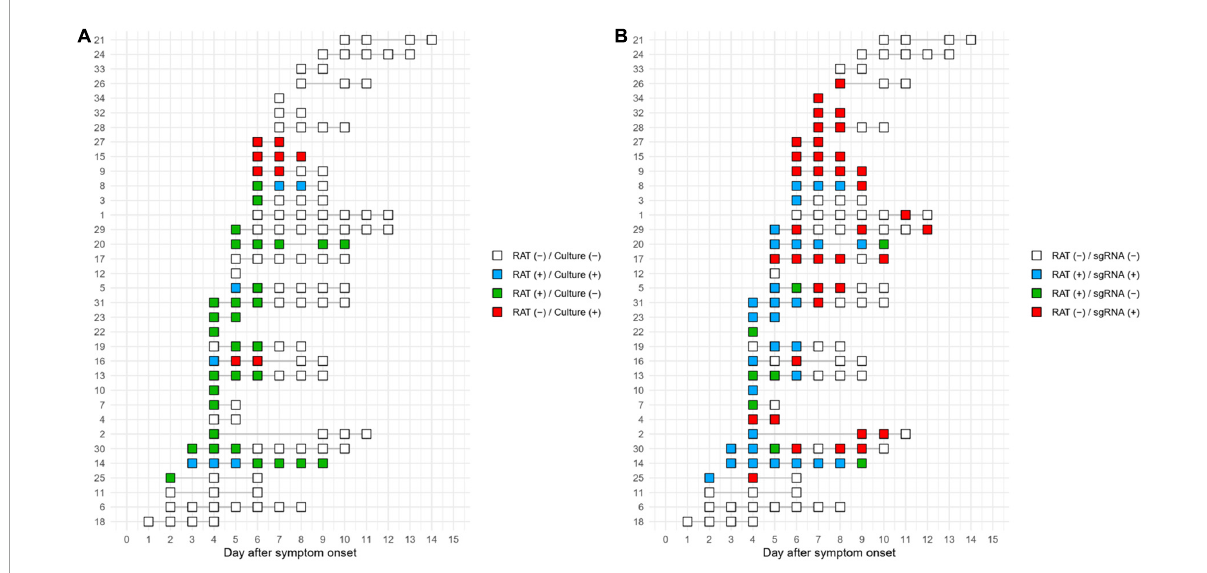
FIGURE4 Timeline of the test results for RAT compared to cell culture (A) or subgenomic RNA (B) . The numbers on the y -axis represent the individual patient